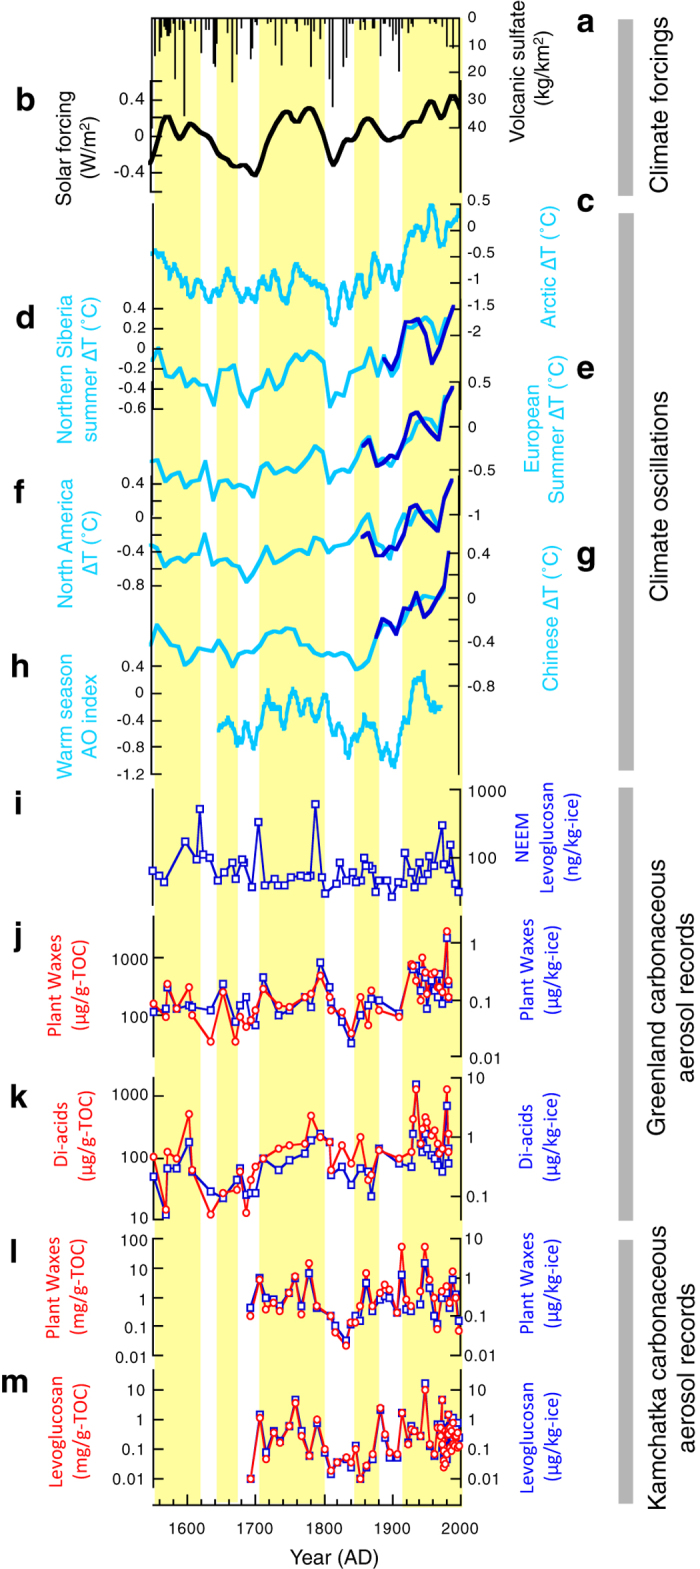
Comparison of carbonaceous aerosol tracers, from the Greenland Site-J and Kamchatka Ushkovsky ice cores, and climate reconstructions over the past 450 years.(a) Volcanic radiative forcing2. (b) Solar radiative forcing1. (c) Reconstructed Arctic temperatures39. (d) Reconstructed Northern Siberian summer temperatures40. (e) Reconstructed European summer temperatures40. (f) Reconstructed North American annual mean temperatures40. (g) Reconstructed Chinese summer temperatures40. The blue lines in figs d–g represent the instrumental temperature record. (h) Reconstructed warm season Arctic Oscillation (AO) index47. (i) Concentrations of levoglucosan in NEEM ice core15. (j) Concentration of long-chain monocarboxylic acids (leaf-waxes) in the Site-J ice core16. (k) Concentrations of long-chain dicarboxylic acids (di-acids) in the Site-J ice core. (l) Concentrations of long-chain monocarboxylic acids (leaf-waxes) in the Ushkovsky ice core. m) Concentrations of levoglucosan in Ushkovsky ice core13. Blue square and red circle in figs i-l show concentrations per kg-ice and TOC-normalized concentrations of organic tracers, respectively. Yellow shading represents relatively warm periods.